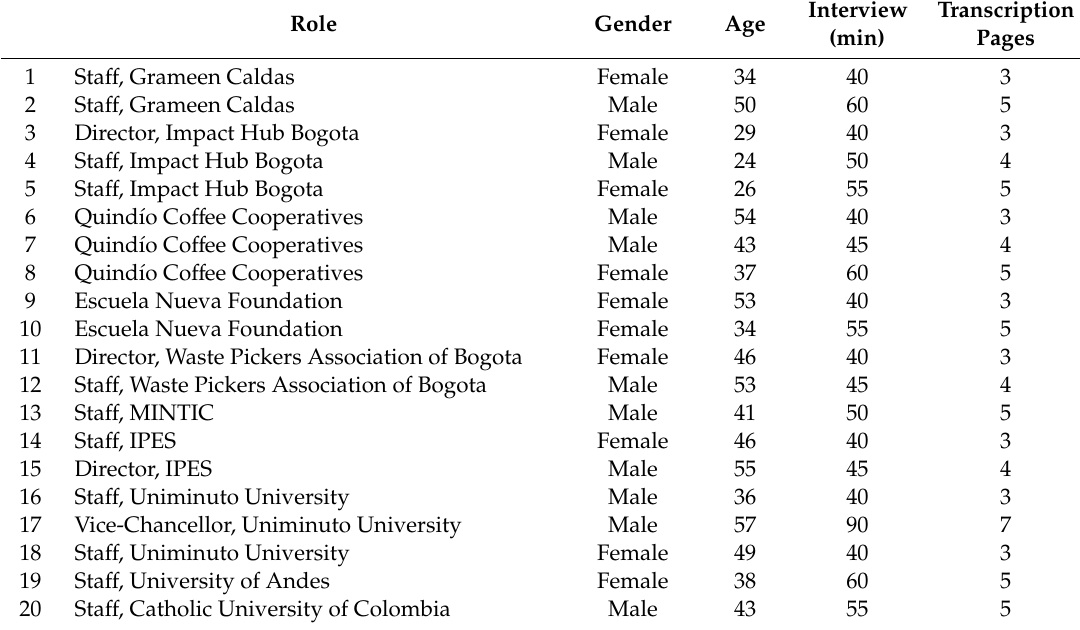
Table 2. Data collection from semi-structured interviews.